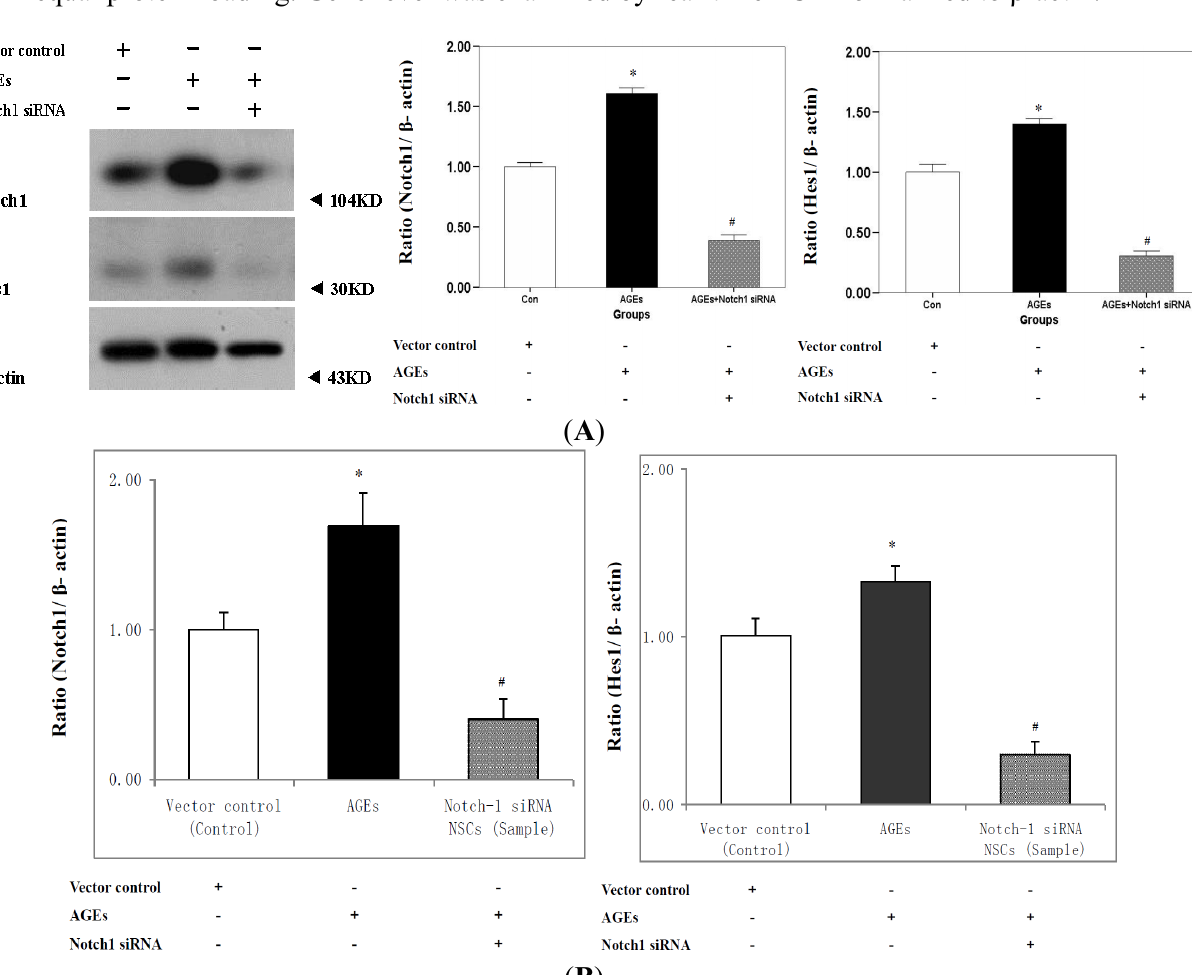
AGE-BSA decreased the protein and gene expression of Notch1 and Hes1 in Notch1-silenced NSCs compared with normal NSCs. Notch1 protein expression was downregulated 19.6% and Hes1 protein expression was downregulated 27.8% (all p < 0.001), whereas Notch1 gene expression decreased by 28.4% and Hes1 gene expression decreased by 77.4% ( p < 0.001). Figure 3. AGEs stimulated the protein and gene expression of Notch-Hes1 pathway in cultured neurospheres. ( A ) Western blotting shows that AGE-BSA increased protein expression of NICD and Hes1 in the NSCs (Vector control) after 7 days of culture in differentiation medium (* p < 0.05, n = 3). AGE-BSA caused a significant decrease in the protein expression of NICD and Hes1 in Notch1-silenced NSCs compared with that in NSCs ( # p < 0.05, n = 3); and ( B ) Real-time PCR shows that AGE-BSA increased gene expression of NICD and Hes1 in the NSCs (Vector control) after 7 days of culture in differentiation medium (* p < 0.05, n = 3). AGE-BSA caused a significant decrease in the gene expression of NICD and Hes1 in Notch1-silenced NSCs compared with that in NSCs ( # p < 0.05, n = 3). Protein level was examined by Western blotting, β -actin staining was used as a control for equal protein loading. Gene level was examined by real-time PCR normalized to β